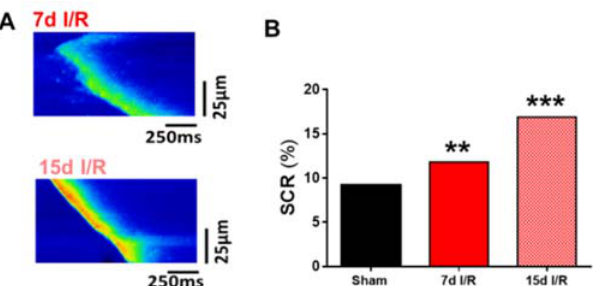
Figure 5. Spontaneous Ca 2+ release in cardiomyocytes after renal I/R. ( A ) Representative line-scan images of cardiomyocytes from mice subjected to ischemia and reperfusion (I/R) for 7 and 15 days. ( B ) Spontaneous Ca 2+ release measured as pro-arrhythmogenic events in cardiomyocytes. Data are presented as % of total analyzed cells. Data are expressed as mean of continuous variables after Fisher test. ** p < 0.01, *** p < 0.001 versus sham; sham ( n = 56 cells, N = 4 mice), 7d I/R ( n = 50 cells, N = 3 mice), 15d I/R ( n = 99 cells, N = 6 mice). In this protocol each cell was recorded 8 consecutive times for 1.5 s. Statistical analyses were performed per scanned ‐ file.